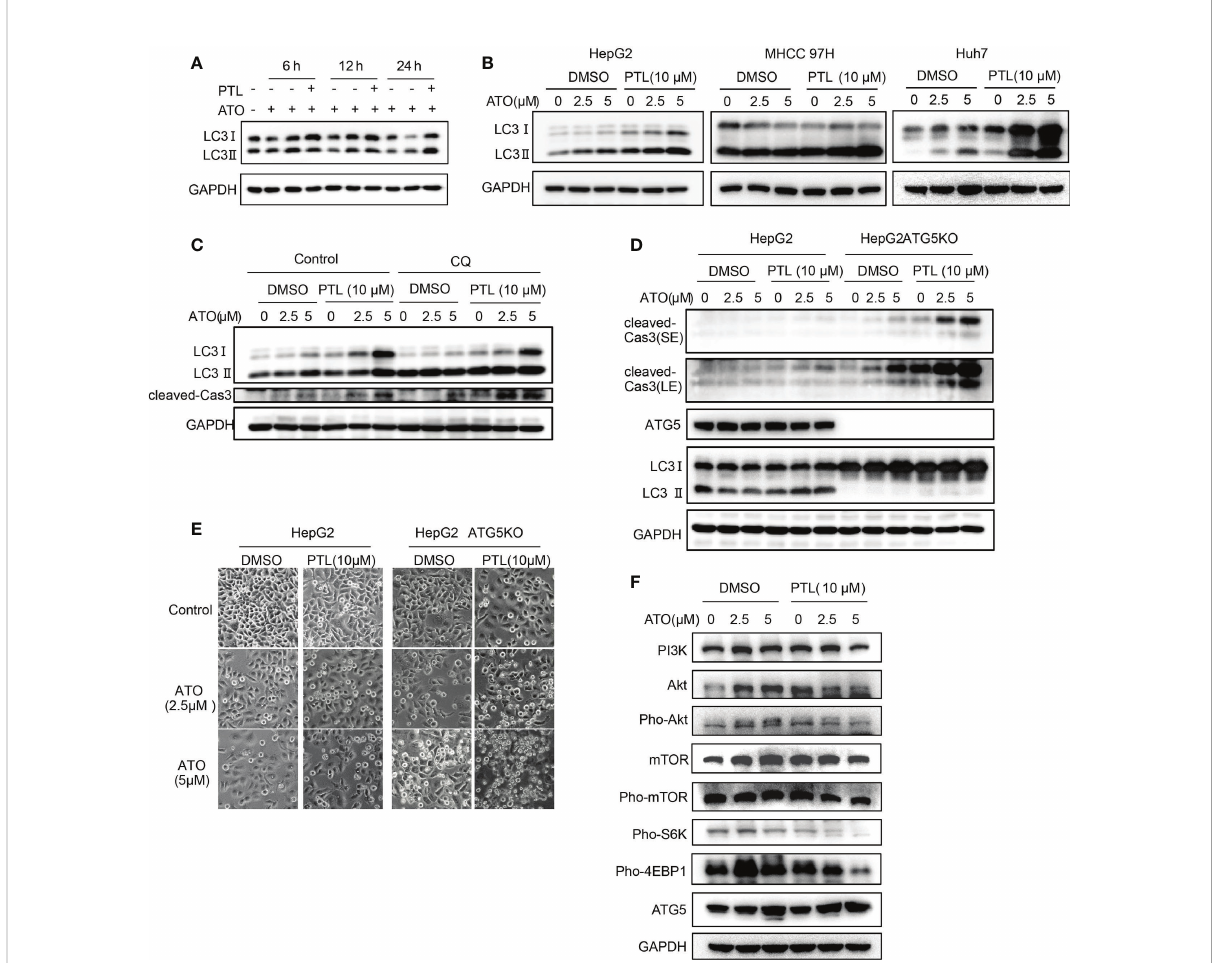
FIGURE 6 PTL enhances ATO-triggered protective autophagy by PI3K/Akt/mTOR pathway in HCC cell lines. (A) HepG2 cells were treated with ATO, PTL and ATO plus PTL for 6 h, 12 h and 24 h. Cells were harvested and subjected to western blotting analysis. (B) HepG2 cells, MHCC97H cells and Huh7 cells were treated with ATO, PTL and ATO plus PTL for 24 h. Cells were harvested and subjected to western blotting analysis. (C) HepG2 cells were treated with ATO, PTL and ATO plus PTL for 24 h with or without 50 m M CQ. Cells were harvested and subjected to western blotting analysis. (D) HepG2 cells and HepG2 ATG5 KO cells were treated with ATO, PTL and ATO plus PTL for 24 h. Cells were harvested and subjected to western blotting analysis. (E) HepG2 cells and HepG2 ATG5 KO cells were treated with ATO, PTL and ATO plus PTL for 24 h. The changes of cell morphology were observed under microscope. Scale bar: 20 m m. (F) HepG2 cells were treated with ATO, PTL and ATO plus PTL for 24 h. Cells were harvested and subjected to western blotting